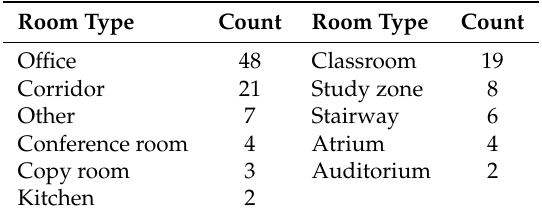
Figure 5. Building OU44 at campus Odense, University of Southern Denmark. Table 2. Room types in building